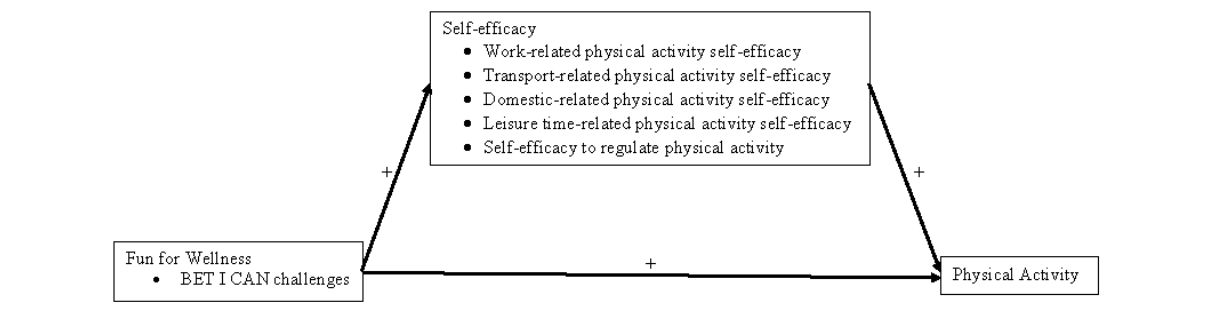
Figure 1. The Fun for Wellness conceptual model for the promotion of physical activity. BET I CAN: behaviors, emotions, thoughts, interactions, context, awareness, and next